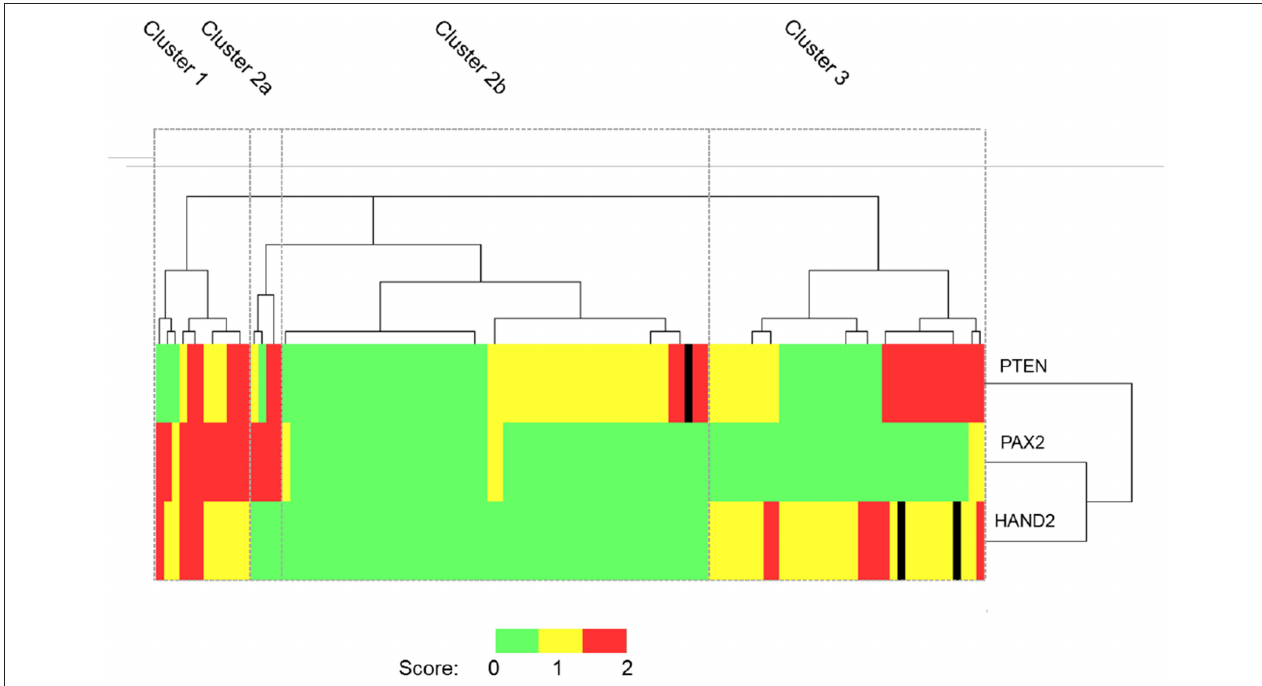
FIGURE 5 | Unsupervised hierarchical cluster analysis of PTEN, PAX2, and HAND2 immunohistochemical staining data. Patient cases orientated along the horizontal axis ( n = 105). Immunohistochemical markers orientated along the vertical axis. Dendrogram branch length represents the similarity between the results obtained. Heat map colors represent outcome of immunohistochemical scoring as described in M&M. On the basis of the staining patterns EH cases were classified into 4 distinct cluster groups according to the dendrogram: Cluster 1 ( n = 12), Cluster 2a ( n = 4), Cluster 2b ( n = 54), and Cluster 3 ( n = 35). PTEN, Phosphatase and tensin homolog; PAX2, Paired box 2 protein, HAND2, Heart and neural crest derivatives-expressed 2. Black lines in the heatmap represent cases where the immunoscore was not available.